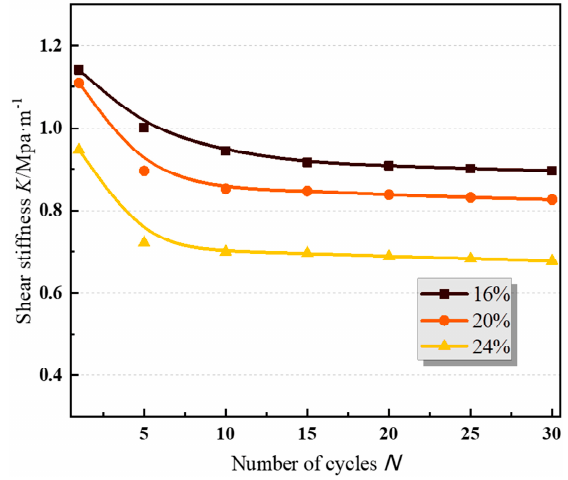
Figure 23. Shear stiffness–cycle number curve under different water content conditions.